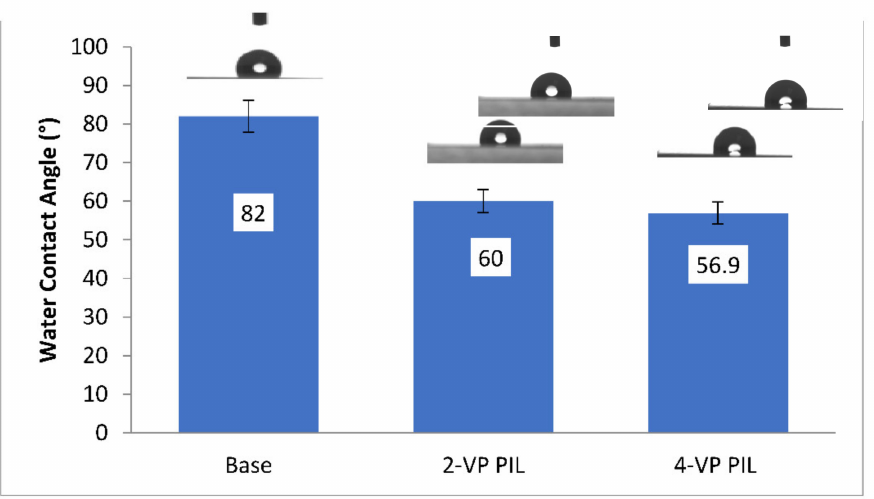
Figure 4. Water contact angle measurements for the Base and PIL Augmented